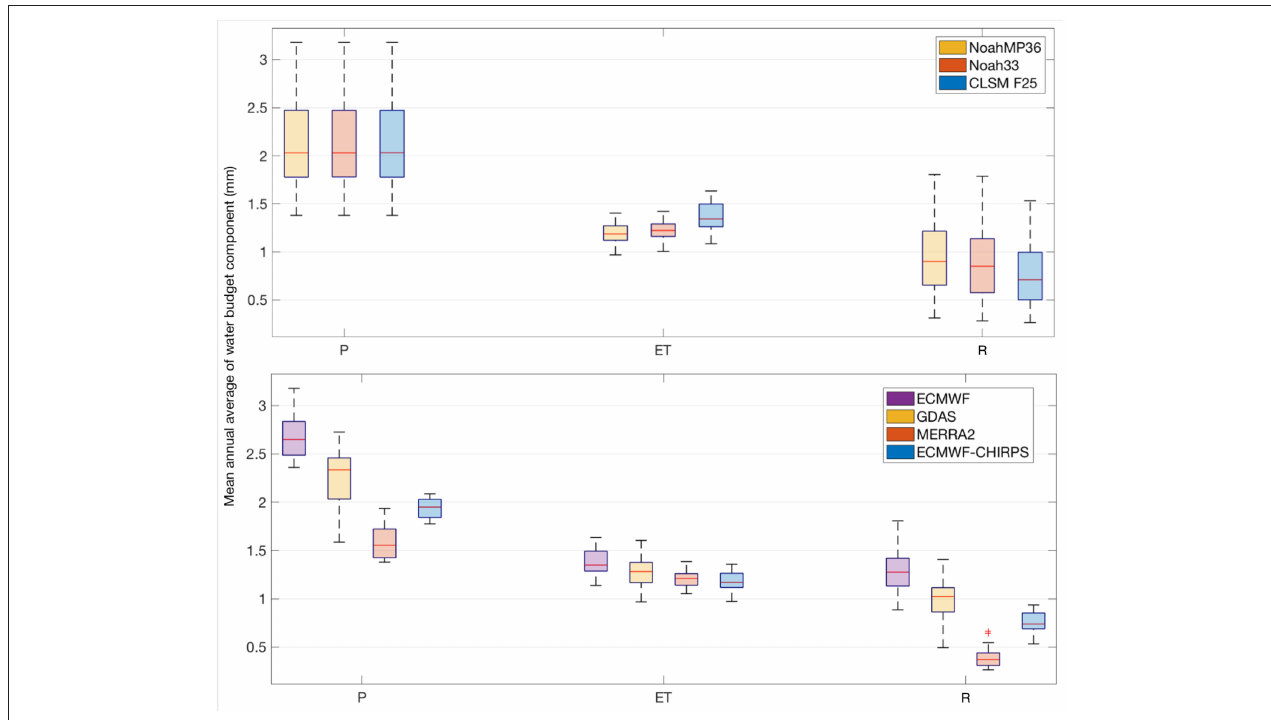
FIGURE 10 | Distribution of the mean annual averages of precipitation ( P ), evapotranspiration ( ET ) and total runoff ( R ), grouped by the LSMs (top panel) and forcing datasets (bottom panel). The units are mm.